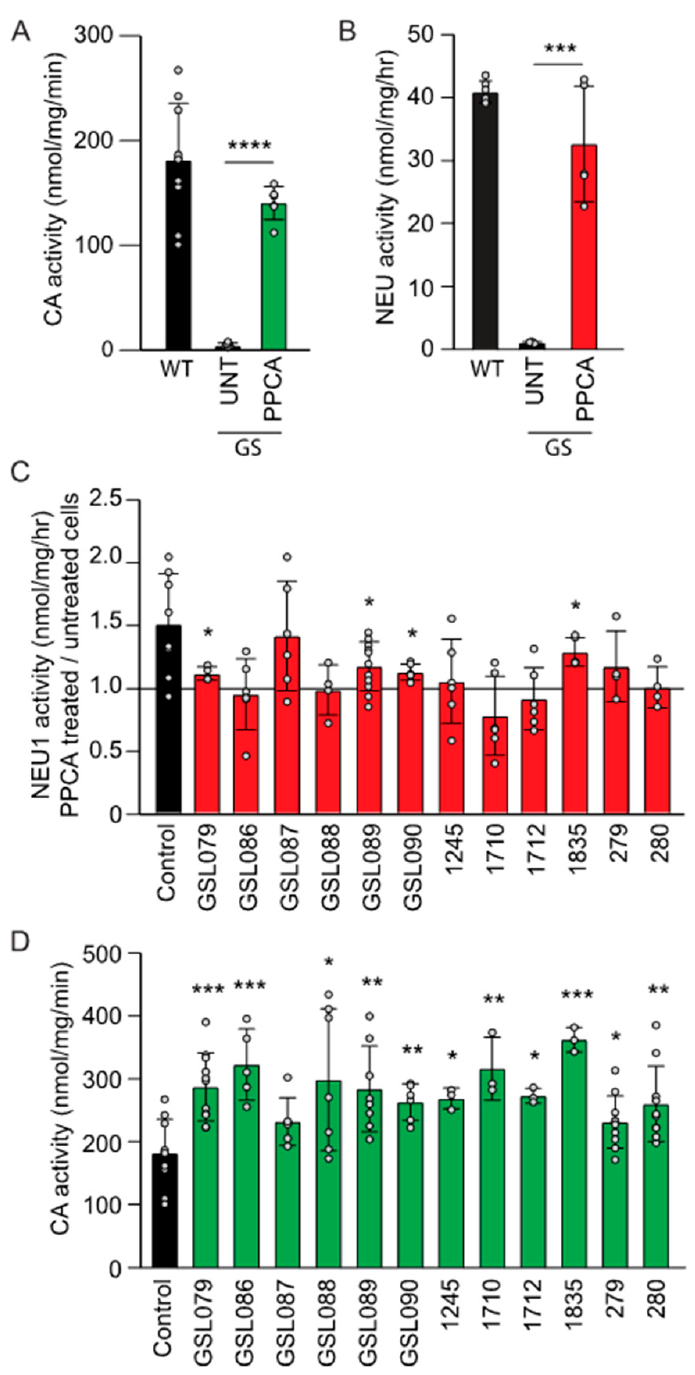
Figure 2. Sialidosis type I fibroblasts respond to treatment with human recombinant protein / cathepsin A (PPCA). ( A ) cathepsin A and ( B ) NEU1 activities assayed in galactosialidosis fibroblasts after addition of recombinant human protective protein / cathepsin A (rhPPCA) ( n ≥ 5) ( C ) Sialidosis type I fibroblasts ( n ≥ 4) assayed for NEU1 activity after addition of rhPPCCA. ( D ) Cathepsin A activity measured in sialidosis type I fibroblasts ( n ≥ 3). Graphs are presented as mean ± SD. Statistical analysis was performed using Student t -test. * p < 0.05, ** p < 0.01, *** p < 0.001, **** p <